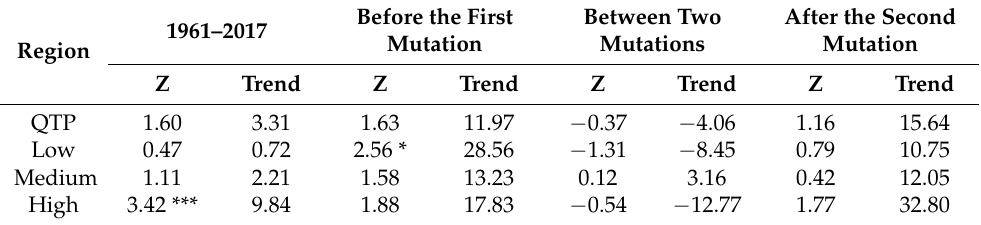
Table 1. Trend ratios and Z-values from the MK test of annual ET 0 on different elevation zones in different